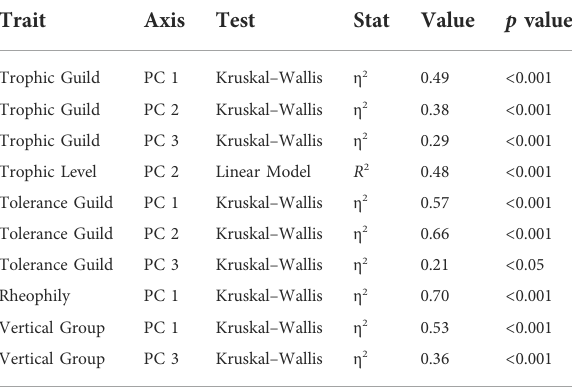
TABLE 2 Traits with signi fi cant effect on axes of the best functional space in PCoA (three-dimensional).